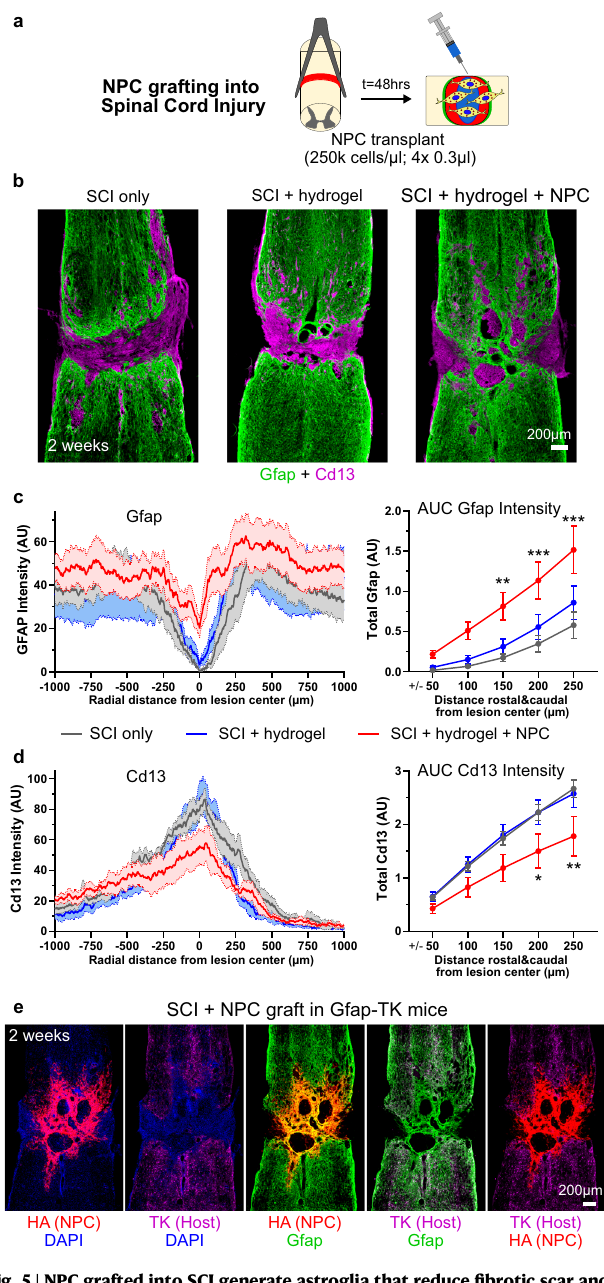
Fig. 5 | NPC grafted into SCI generate astroglia that reduce fi brotic scar and bridge lesions. a Schematic summarizing experimental approach for evaluating NPCgraftinginmousespinalcordinjury(SCI). b SurveyIHCimagesofSCIlesions at 2 weeks comparingeffect of hydrogel aloneor grafted HA-positive NPCon SCI phenotype. NPC grafted lesions show Gfap-positive bridges with reduced Cd13- positive tissue in lesion cores. c Gfap intensity plots and quanti fi cation of total Gfap via an area under the curve (AUC) calculation of Gfap Intensity within de fi ned regions at SCI lesion cores at 2 weeks showing increased Gfap at lesion cores with NPC grafts. d Cd13 intensity plots and quanti fi cation of total Cd13 via an area under the curve (AUC) calculation of Cd13 Intensity within de fi ned regions at SCI lesion cores at 2 weeks showing decreased Cd13 at lesion cores with NPC grafts. For both c , d , N =6 for SCI only, N =5 for gel, N =6 NPC graft, *** p value < 0.0005, ** p value < 0.006, * p value < 0.05. Two-way ANOVA with Tukey multiple comparison test. Gfap and Cd13 intensity plots show mean as darken lines and SEM as shaded area. AUC graphs are mean±s.e.m. e Survey IHC images of NPC grafted SCI lesions at 2 weeks in GFAP-TK mice showing contribution of grafted NPC to the Gfap-positive tissue at the lesion core. AU arbitrary